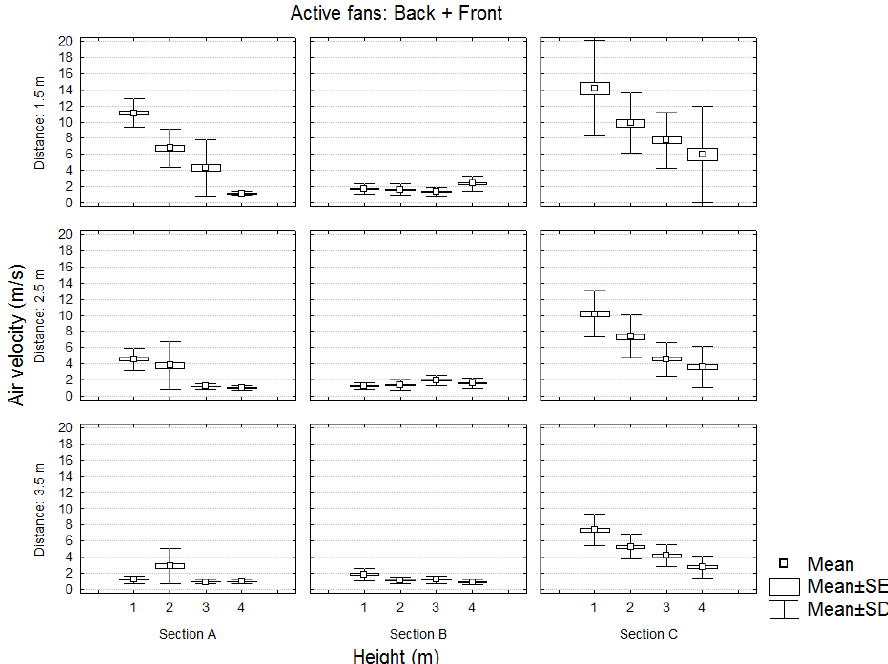
Figure 8. Static test of the sprayer with the back and front fans powered. Air velocity values for each section in function of the height and distance of the measurement